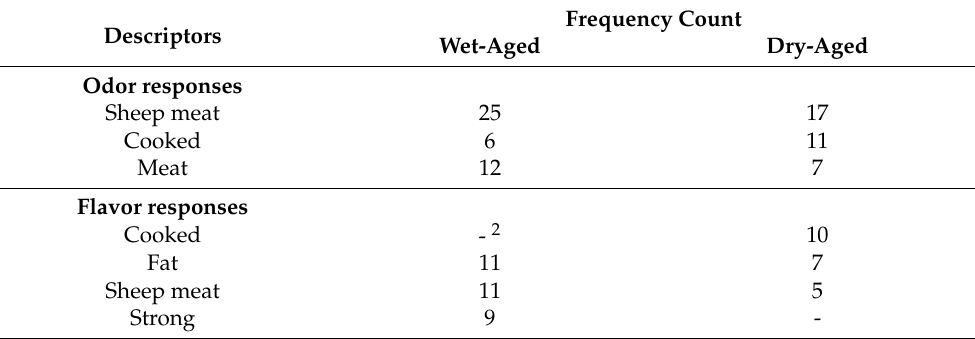
Table 2. Effect of ageing method (dry vs. wet) on frequency (count) of top three descriptor terms for odor and flavor of cooked mutton patties for top-of-mind questions 1